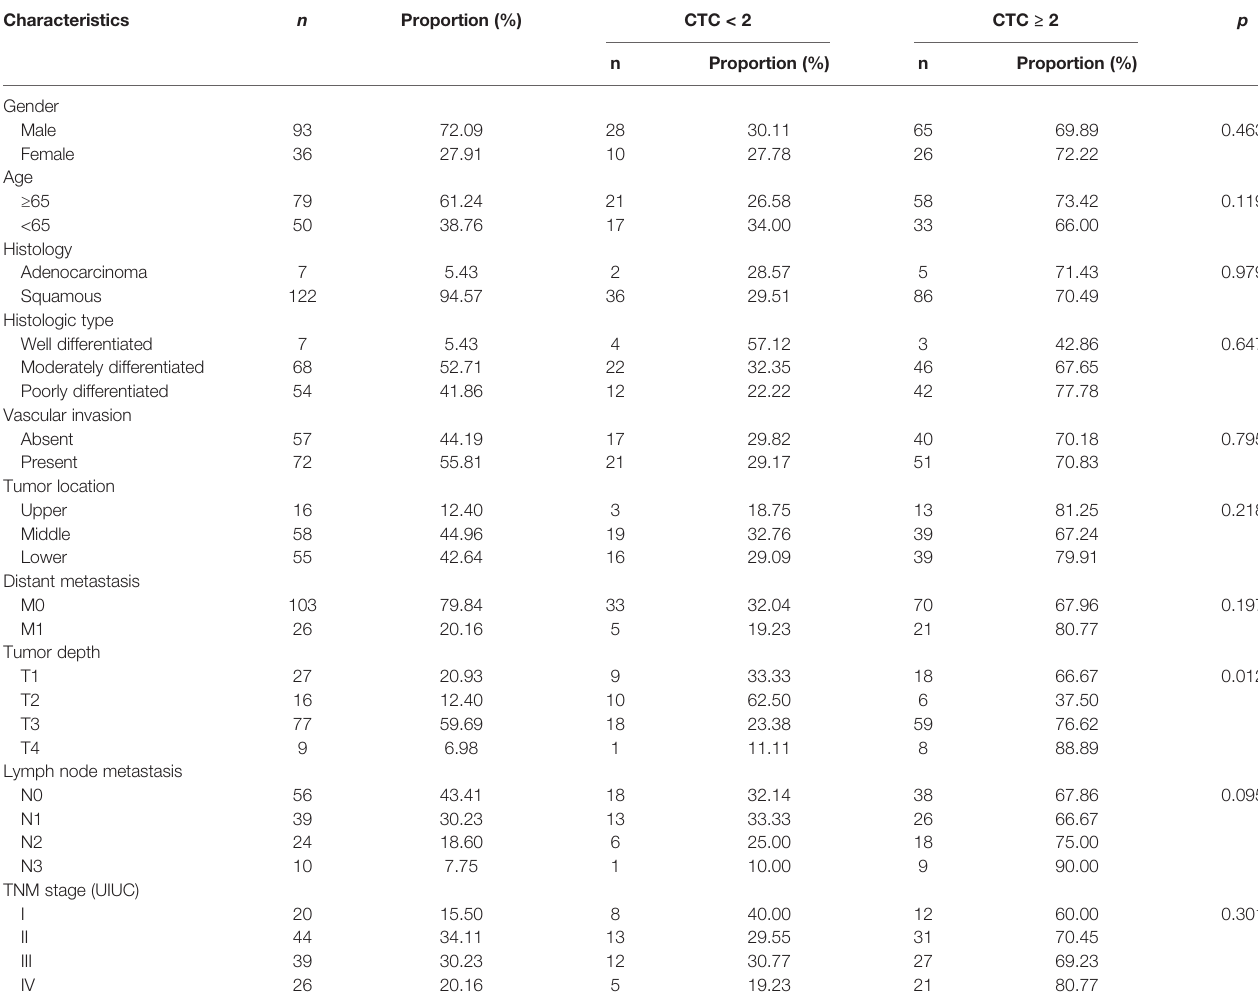
TABLE 1 | Relationship of CTC with patient demographics and clinical